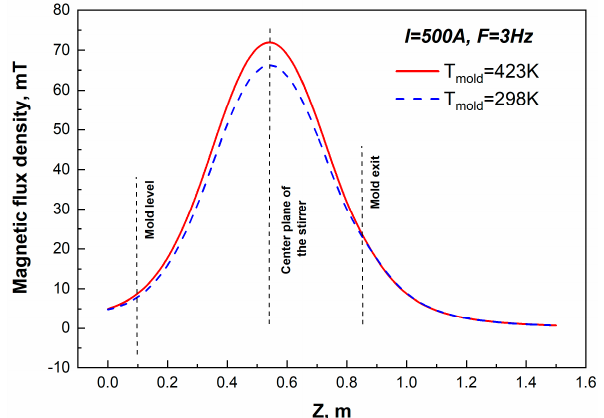
Figure6. Distributionofmagneticfluxdensityalongthestrandcentralaxisunderthemoldtemperatures Figure 6. Distribution of magnetic flux density along the strand central axis under the mold of 298 and 423 temperatures of 298 and 423 K.